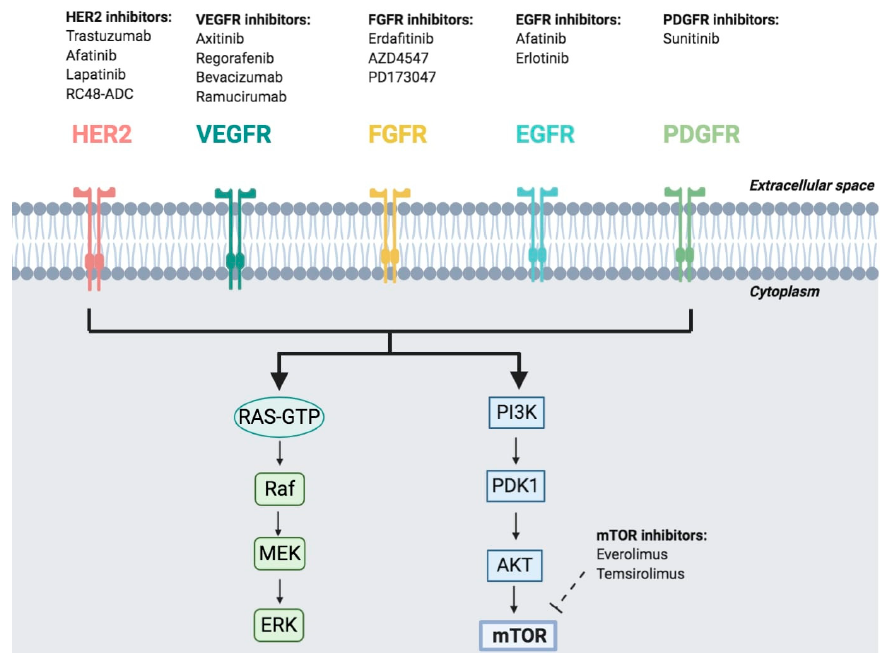
Figure 2. Frequent potentially actionable mutations and pathways involved in UC. EGFR: epidermal growth factor receptor; ERK: mitogen-activated protein kinase; FGFR: fibroblast growth factor receptor; HER2: receptor tyrosine-protein kinase ERBB2; MAPK: mitogen-activated protein kinase; MEK: dual-specificity mitogen-activated protein kinase; mTOR: mammalian target of rapamycin; PDGFR: platelet-derived growth factor receptor; PI3K: phosphoinositide 3-kinase; PTEN: phosphatase and tensin homologue; VEGFR: vascular endothelial growth factor receptor. FGFR1, FGFR2, FGFR3, FGFR4 are tyrosine kinases receptor that have been found altered